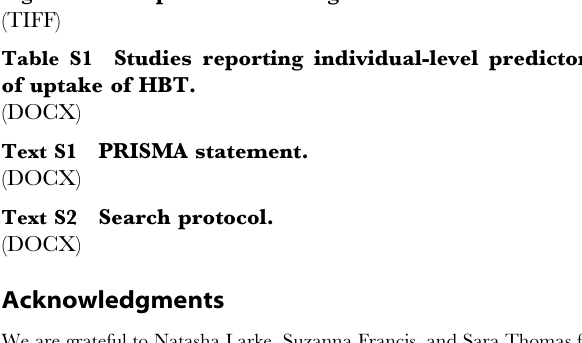
Figure S1 Proportion receiving result of HBT. Table S1 Studies reporting individual-level predictors of uptake of